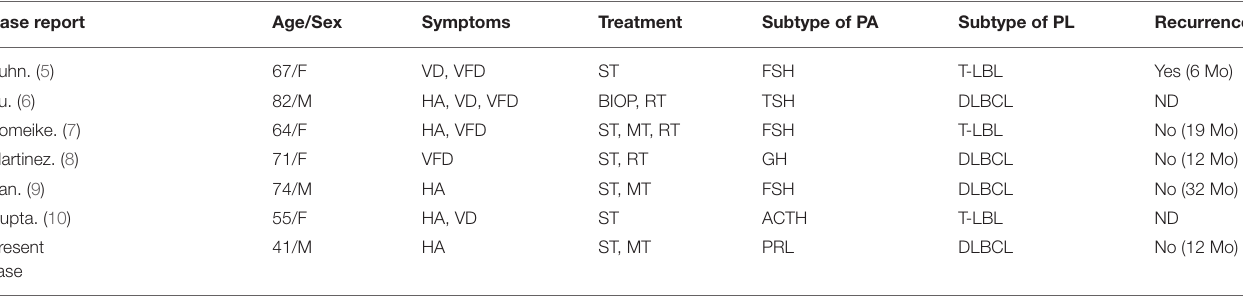
TABLE 3 | Summary cases of coexistence of pituitary adenoma and pituitary lymphoma. Case